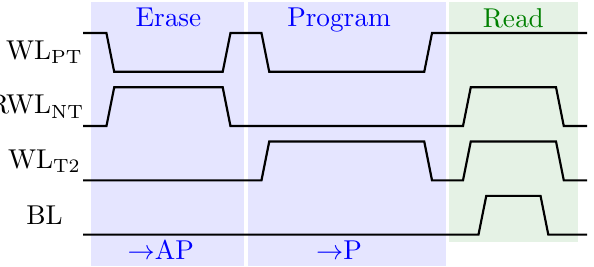
Figure 5. Timing diagram of write and read operations for the NAND-SPIN over MTJ2.